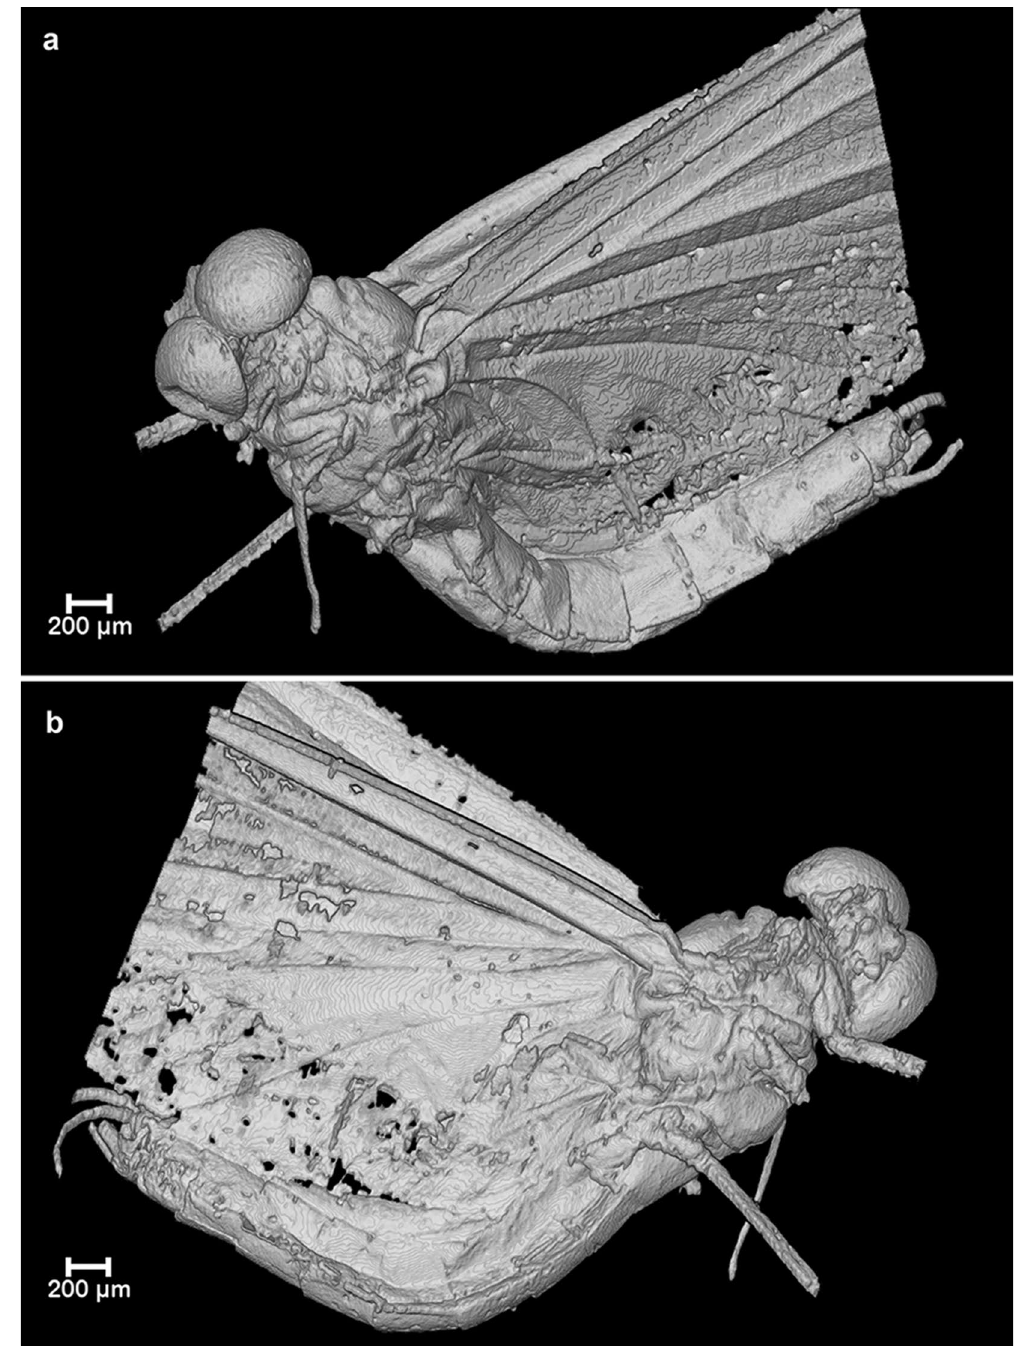
Figure 3. Micro-CT volume-rendered images of Calliarcys antiquus sp. nov. , holotype, male imago; Eocene Baltic amber; BB 2515 [SMNS coll.]; ( a ) body in left lateral view; ( b ) body in right lateral